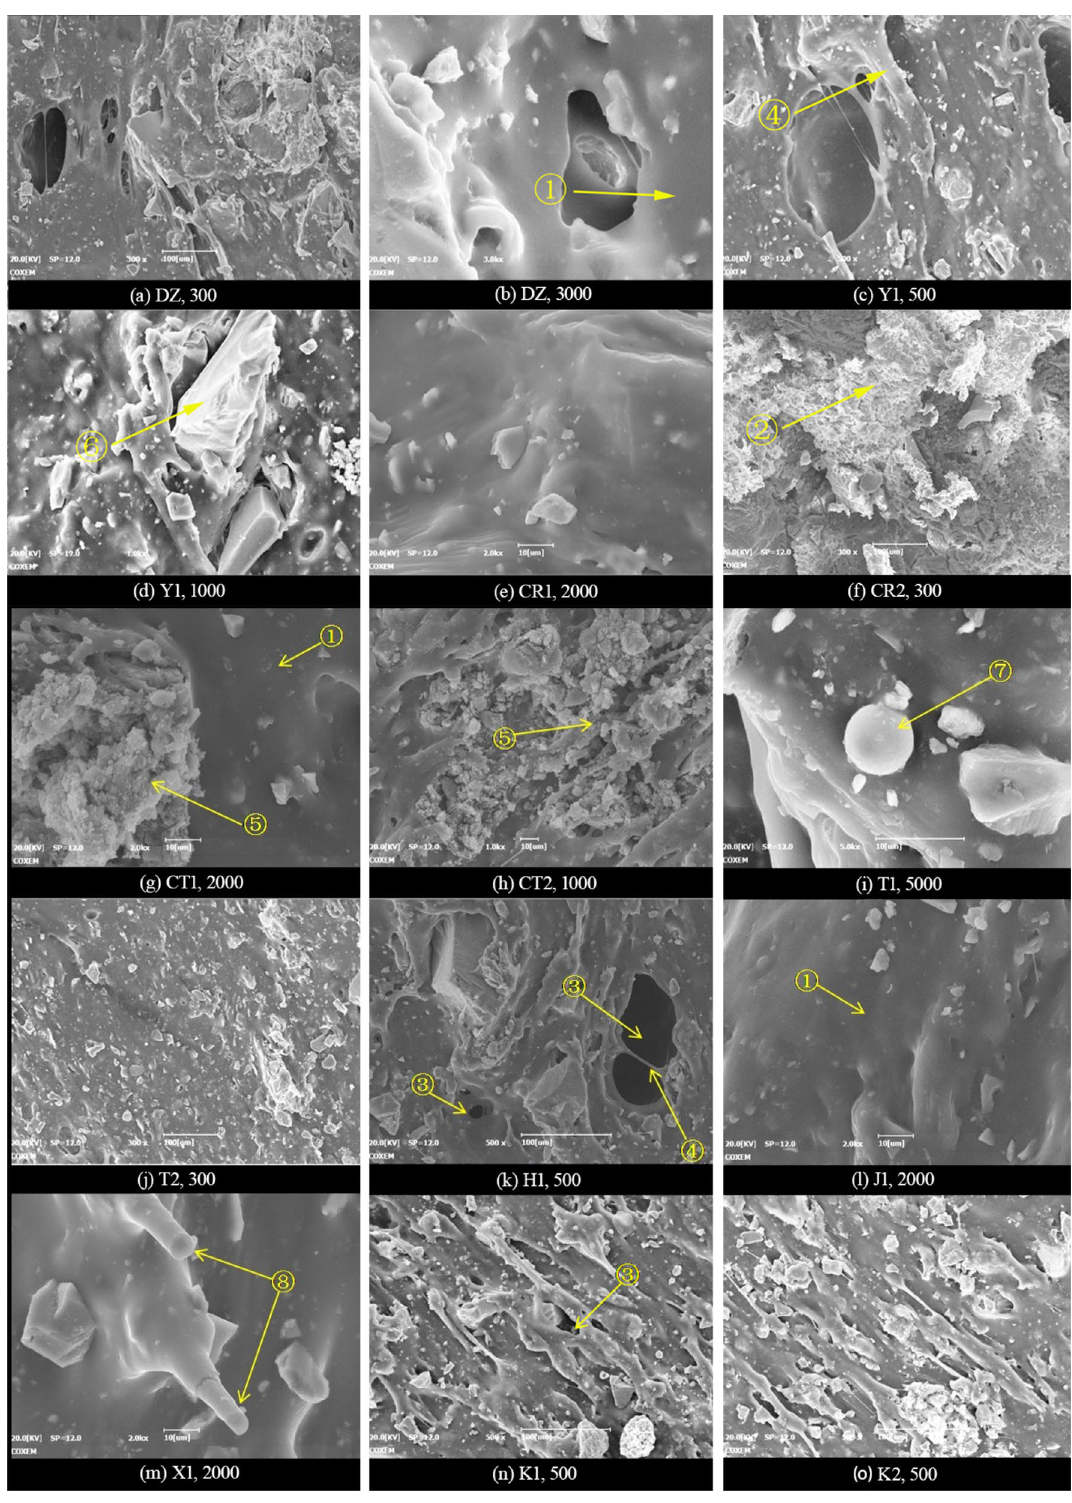
Figure 9. Typical microstructure of polymer-cement composite joint sealant. ① Polymer film; ② Interpenetrating network formed by polymer and inorganic fractions; ③ Pores; ④ Polymer film transversely penetrating pores; ⑤ Aggregates formed by filler materials and cement hydrates; ⑥ Wrapped inorganic fraction; ⑦ Unhydrated cement particles; ⑧ Wrapped carbon